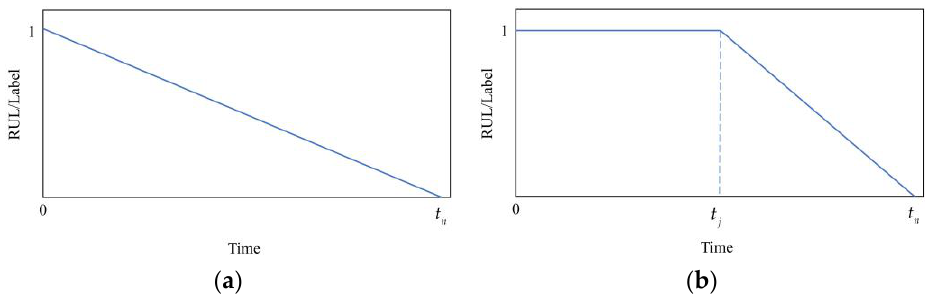
Figure 12. Two function curves describing the labeling method: ( a ) linear function; ( b ) piecewise function.